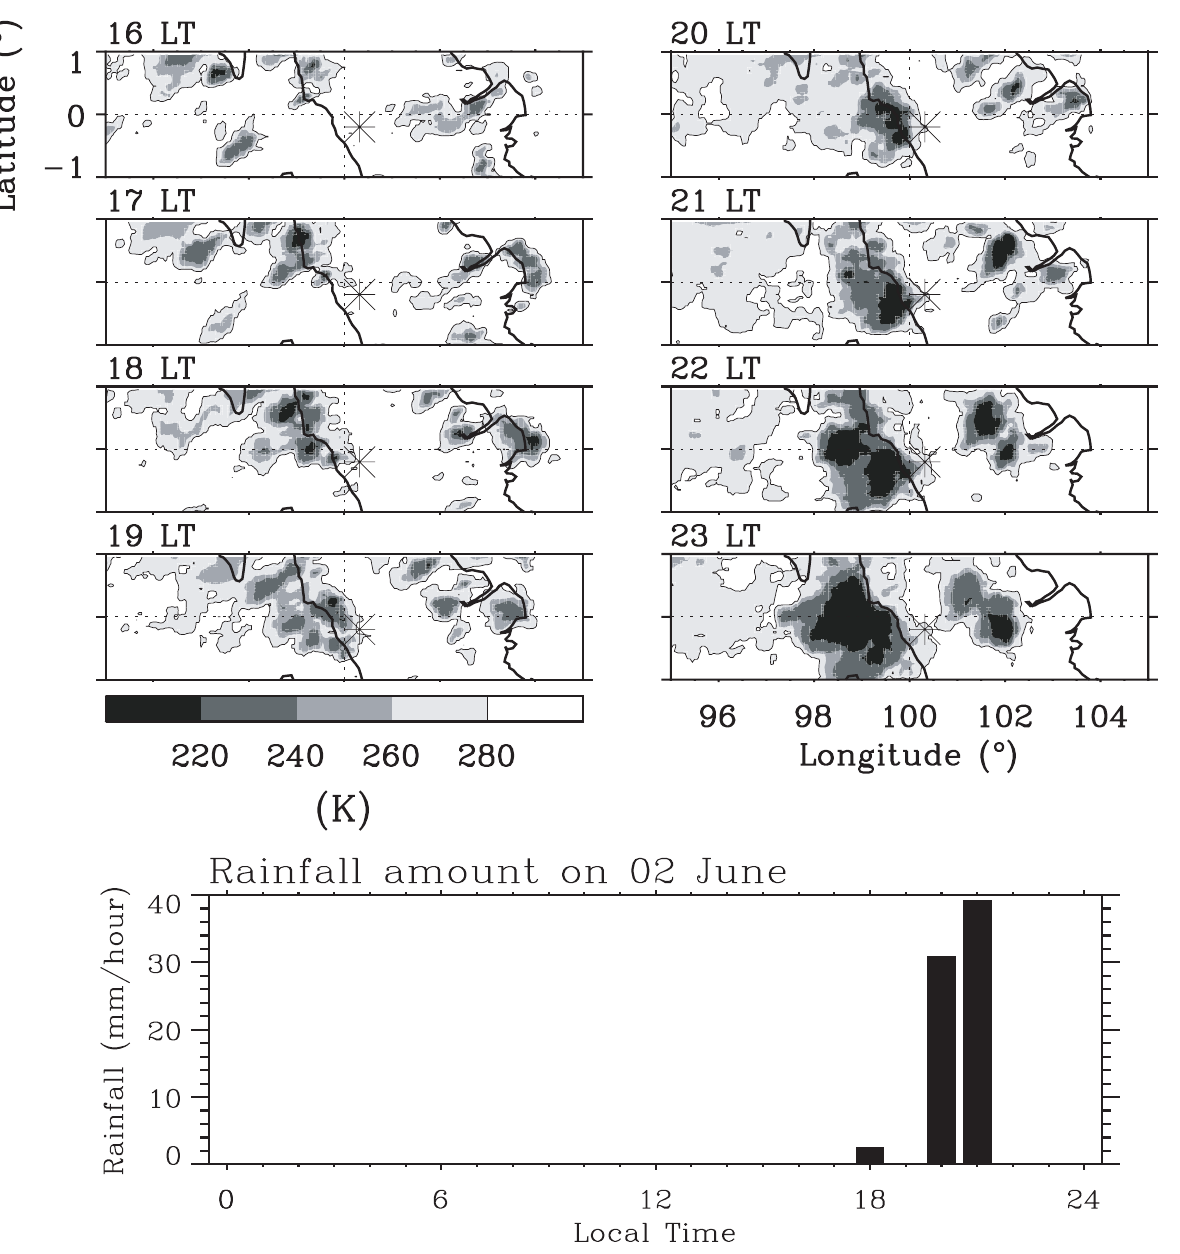
Fig. 15. Longitude-latitude plot of T BB at 16:00–23:00 LT (upper panel) and hourly rainfall (lower panel) on 2 June 2002. Spatial resolution of T BB is 0 . 05 ◦ × 0 . 05 ◦ . “*” in the upper panel indicates the location of the observation